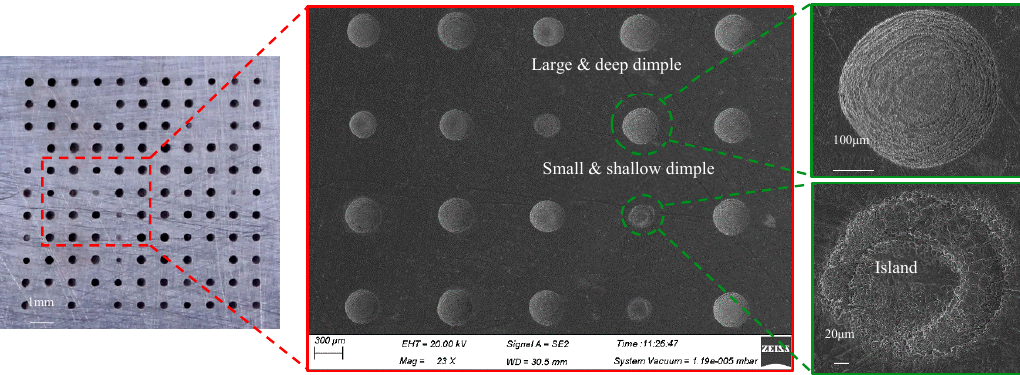
Figure 5. Morphologies of the arrayed micro ‐ dimples machined in the single ‐ travel mode and without the magnetic field (single ‐ travel time of 0.3 s, 8.5 V).